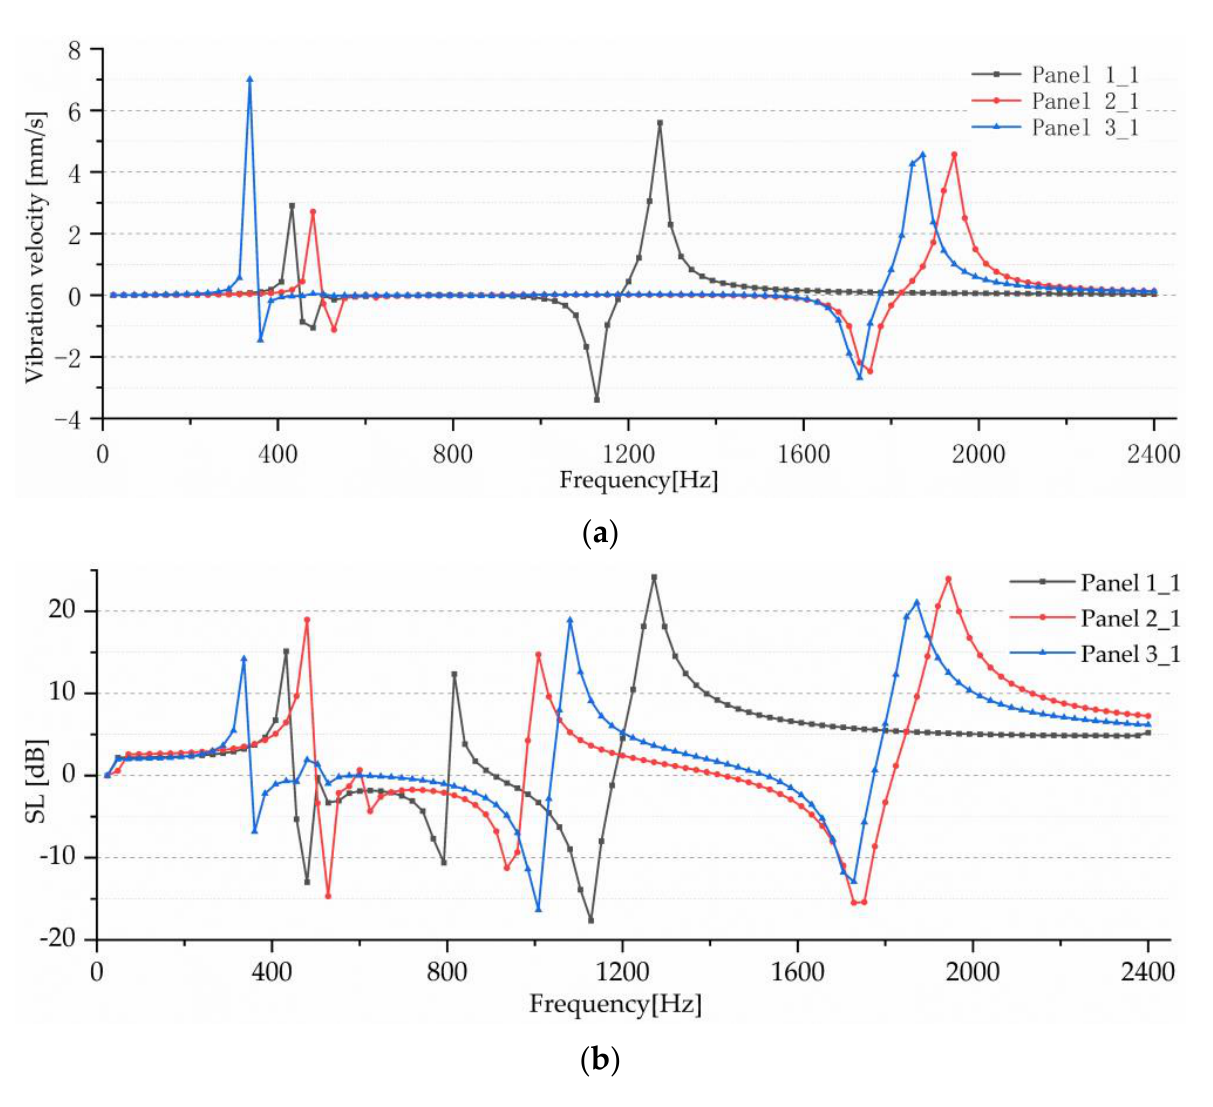
Figure 12. Simulation results of honeycomb panels. ( a ) Surface vibration velocity. ( b ) SL.